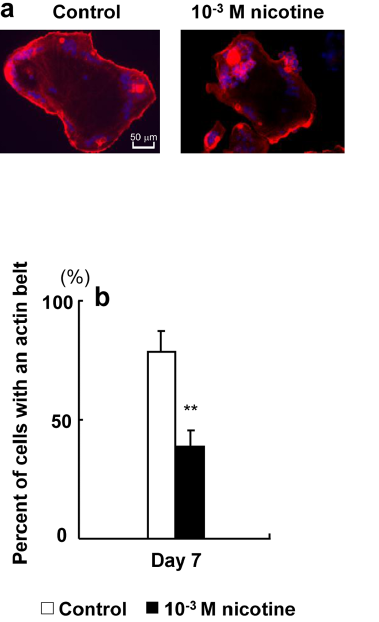
Figure 7. Effect of nicotine on actin organization. RAW264.7 cells were plated onto 12-mm coverslips. The cells were cultured with 0 (control) or 10 2 3 M nicotine in differentiation medium for 7 days and then fixed. Filamentous actin was labeled with fluorescently tagged phalloidin (red), nuclei were labeled with 4 9 ,6-diamidino-2-phenylindole (DAPI, Vector Laboratories) (blue), and osteoclasts were observed by fluorescence microscopy. Representative micrograph of osteoclasts on a coverslip (original objective, 6 40) (a). The percentage of osteoclasts exhibiting actin belts under each condition was quantified (b). Data are expressed as the mean 6 S.D., n=3 independent experiments, each performed using triplicate coverslips with five randomly selected osteoclasts analyzed per coverslip. ** p , 0.01 nicotine treatment vs. control.